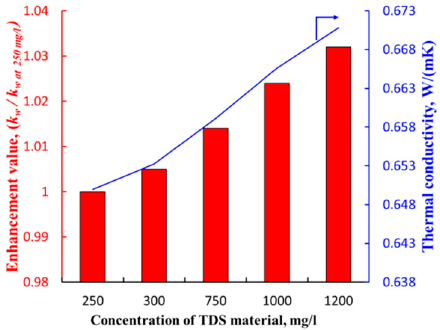
Figure 11. Variation of the enhancement of thermal conductivity with concentration of TDS material.